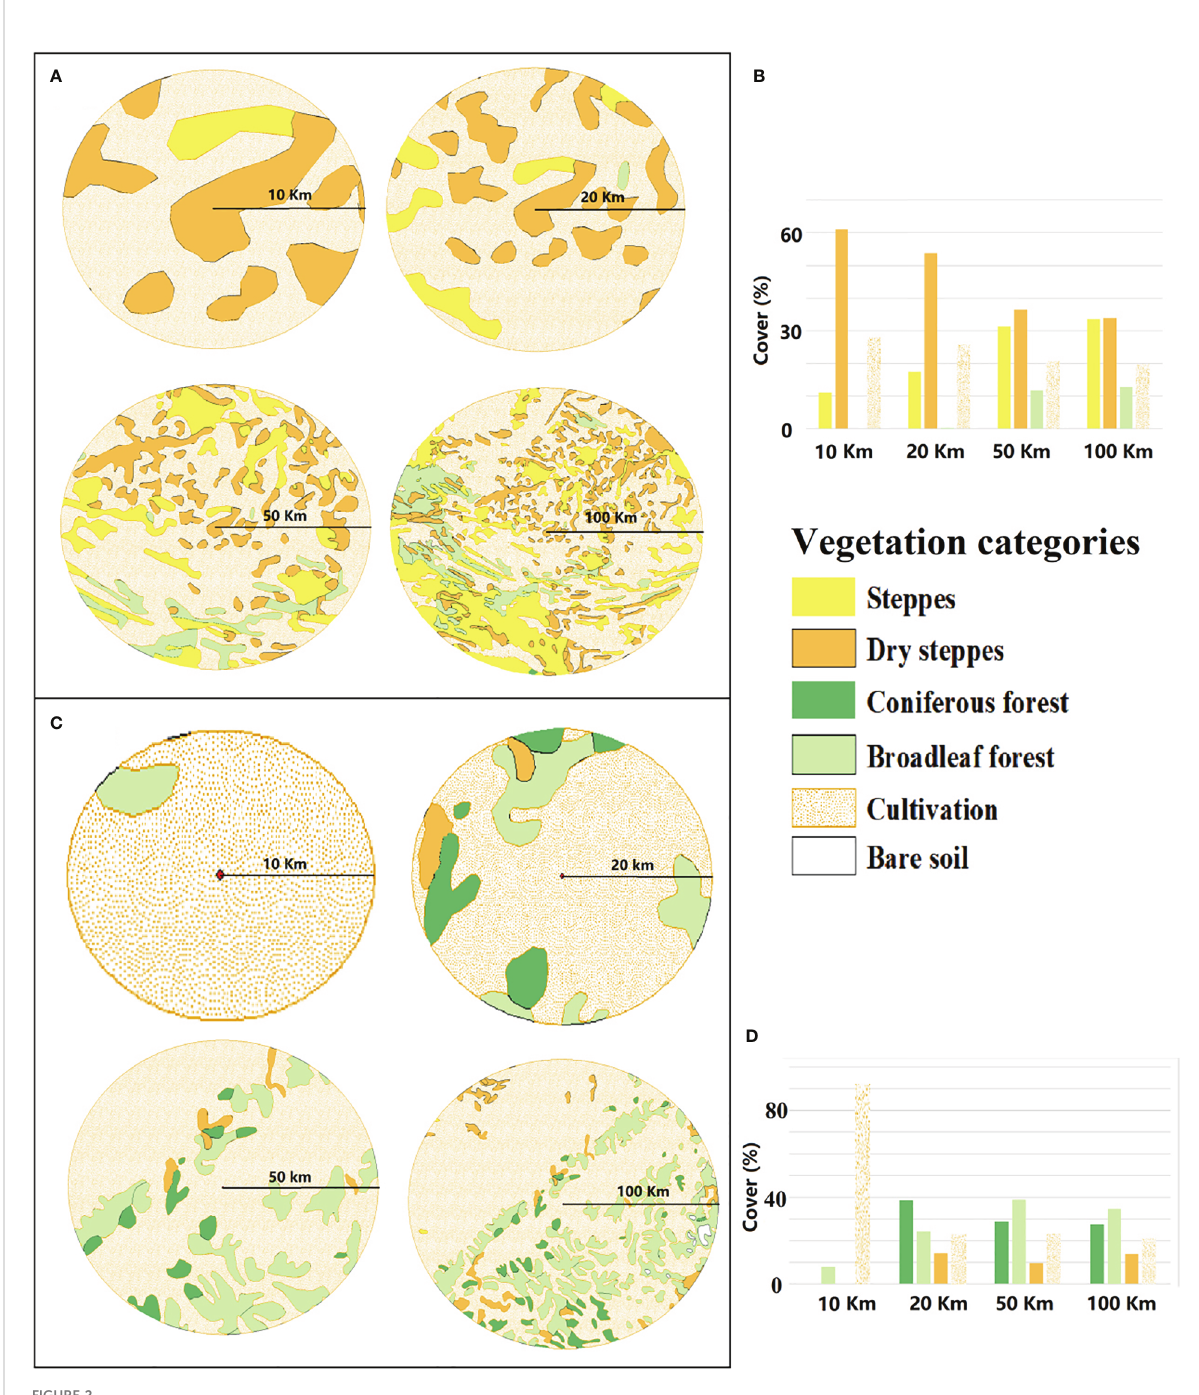
FIGURE 2 Vegetation maps (http://www.geodata.cn) for extended radii of 10, 20, 50, and 100 km from the pollen record site for central and marginal regions. (A) . Vegetation maps for central region. (B) . Percentage cover of the different vegetation categories of central region. (C) . Vegetation maps for marginal region. (D) . Percentage cover of the different vegetation categories of marginal